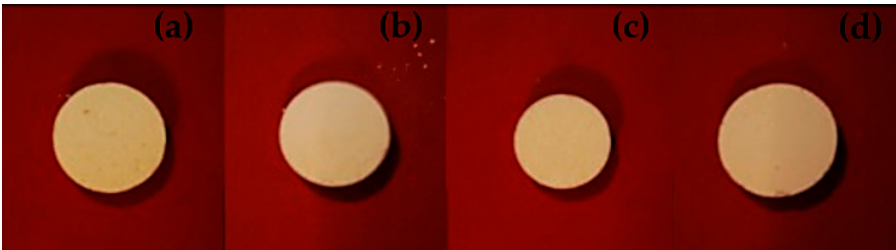
Figure 1. Example photograph of composites fabricated by the sol–gel method ( a ) CS/Si/HAp; ( b ) CS/Si/HAp/Na-GP; ( c ) CS/Si/Na-GP; ( d ) CS/Si/HAp/Ca-GP.